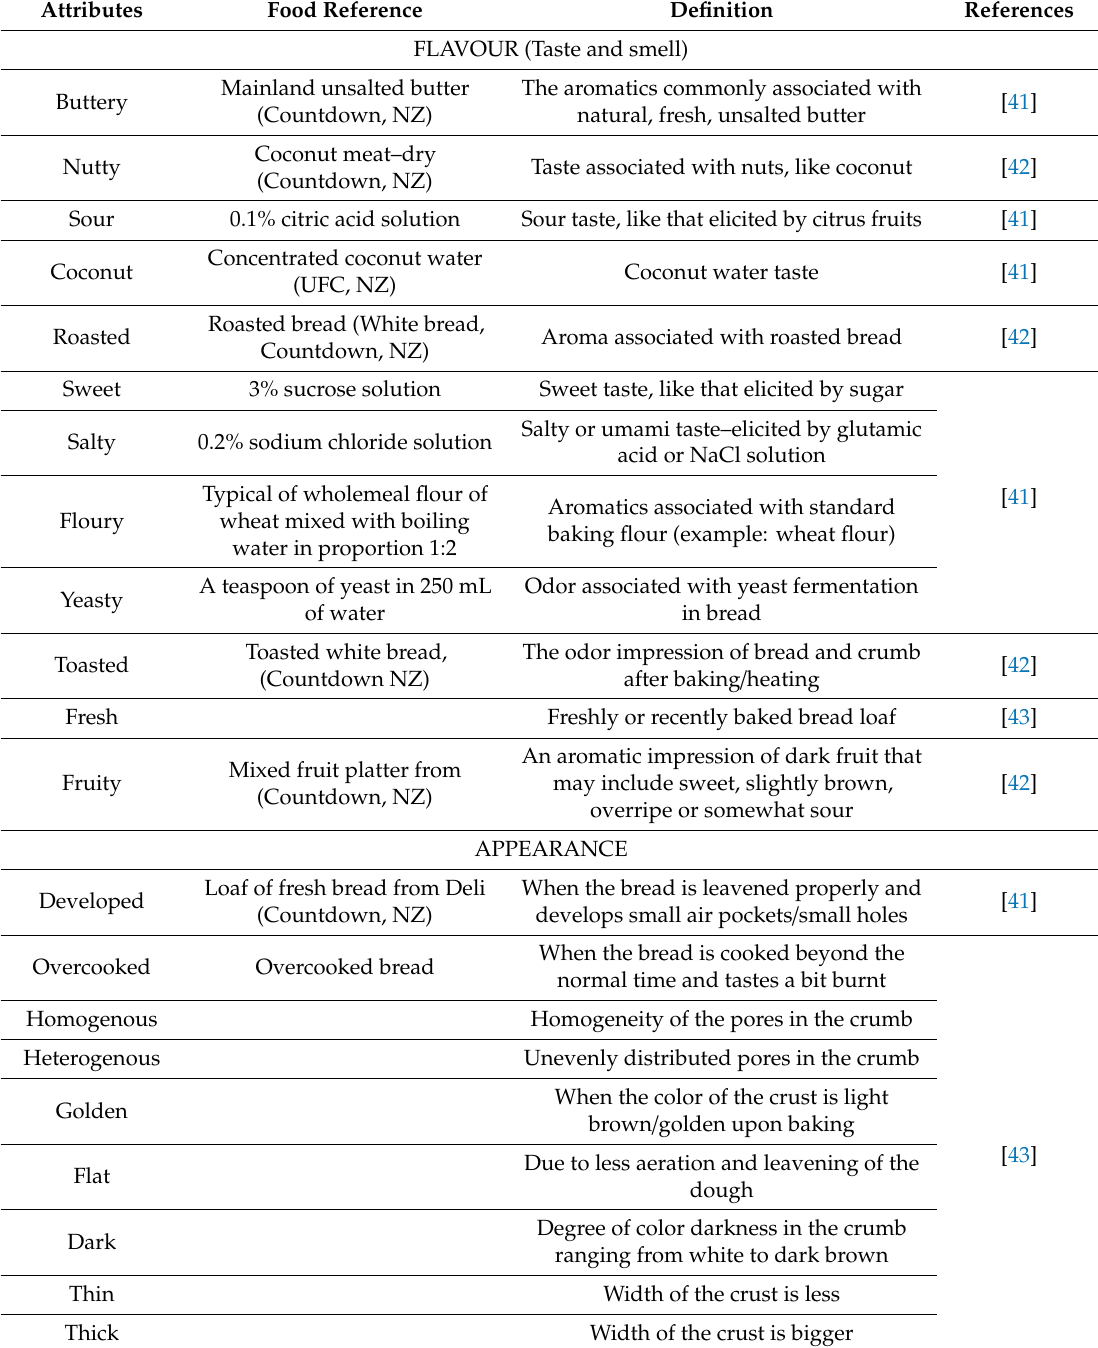
Table 2. List and description of sensory attributes used in sensory testing using CATA